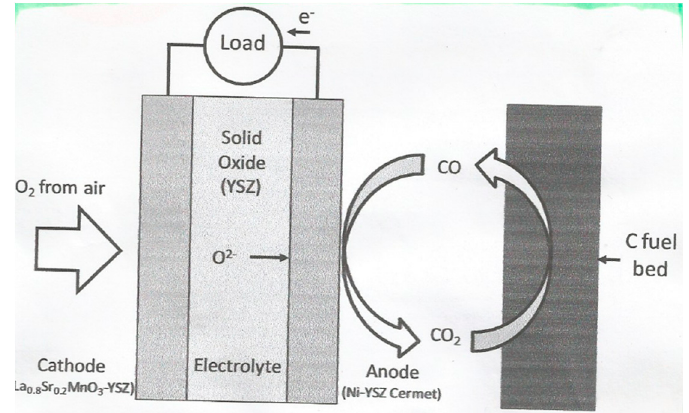
Figure 13. Operating schematic of a gasification-driven direct carbon solid oxide fuel cell (SOFC).